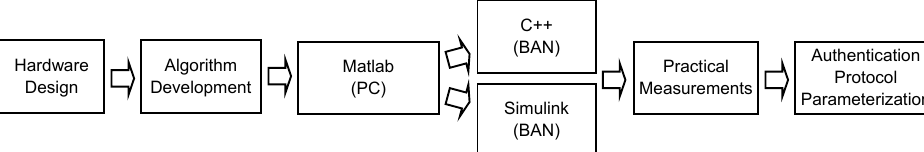
Figure 3. Development